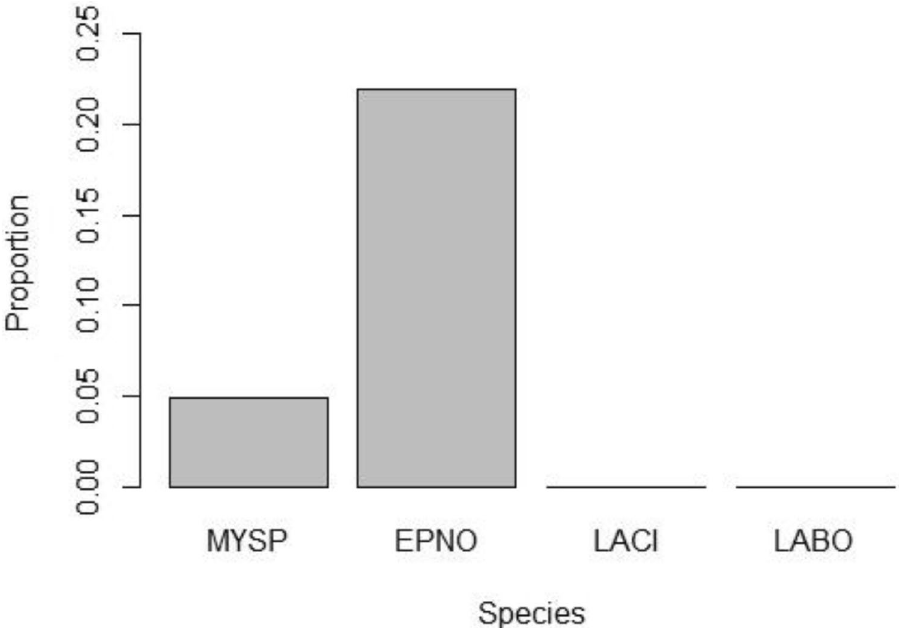
Figure 3. Proportion of bat passes detected per species group with and without a UAV. These rates were obtained by dividing the results of Phase 2 (drone flight) by the average of Phases 1 and 3 (before and after drone flights) 26 .